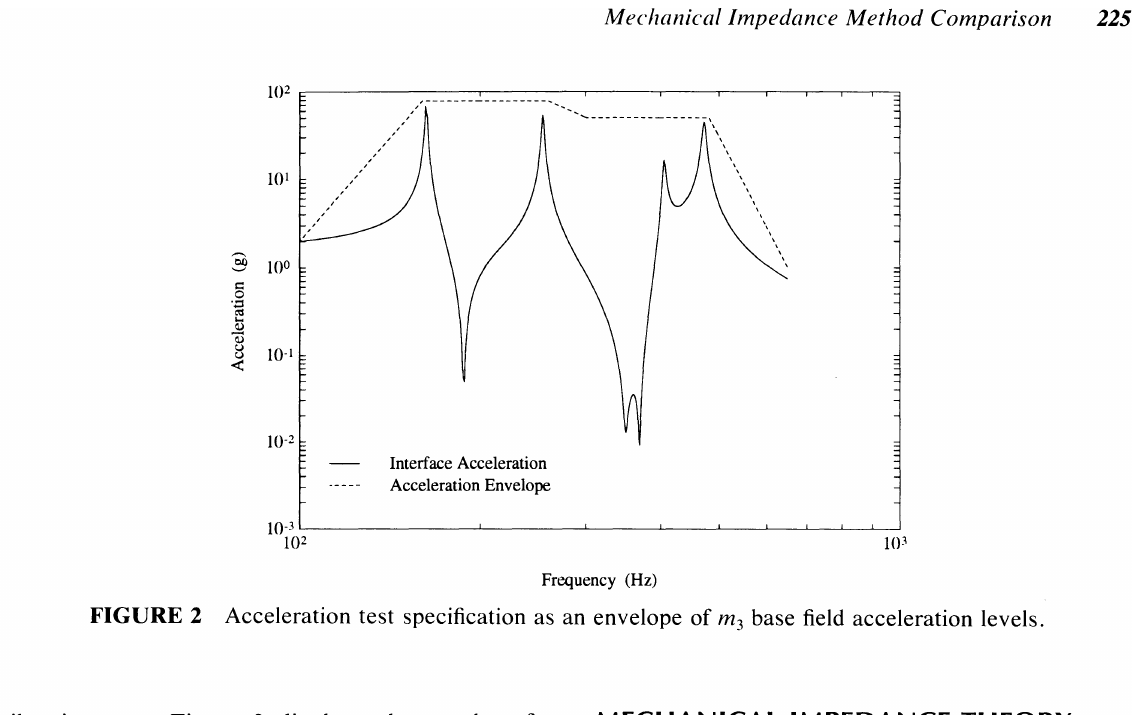
FIGURE 2 Acceleration test specification as an envelope of m3 base field acceleration levels.